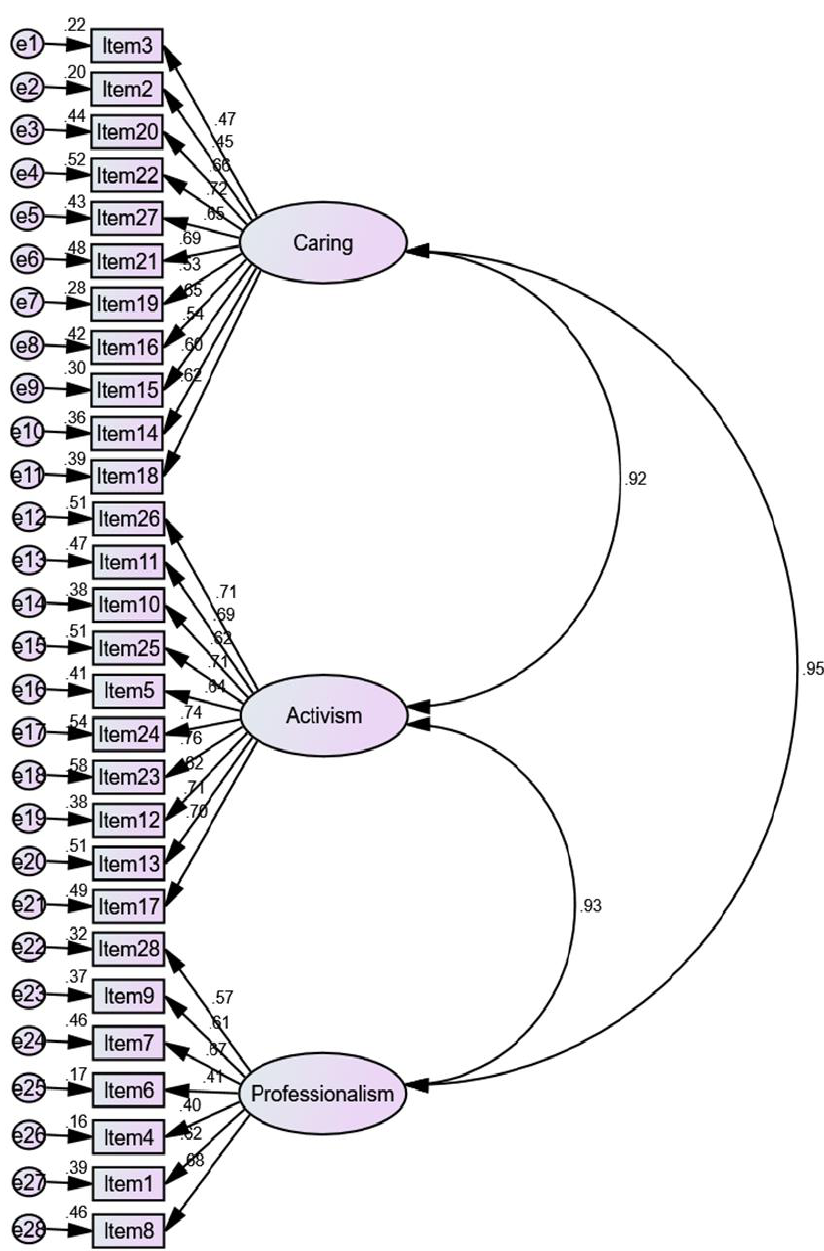
Figure 1. Confirmatory factor analysis for the Indonesian version of the Nurses Professional Values Scale-3 ( n = 300).